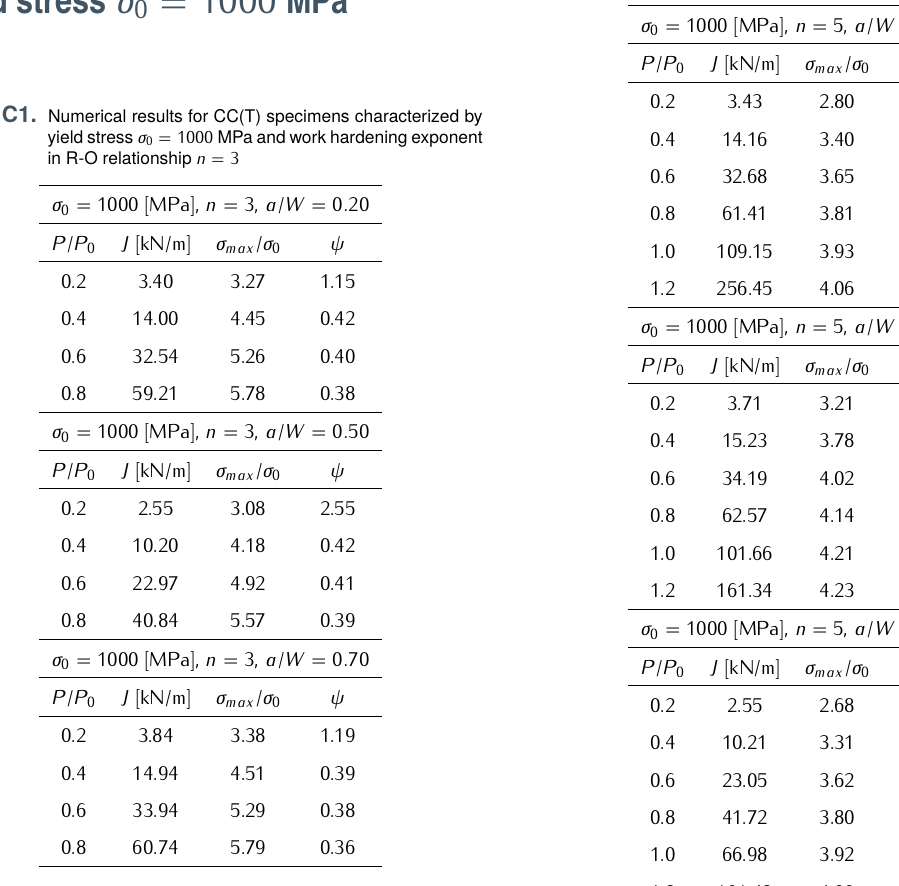
Table C2. Numerical results for CC(T) specimens characterized by yield stress σ MPa and work hardening exponent 0 = 1000 in R-O relationship n =